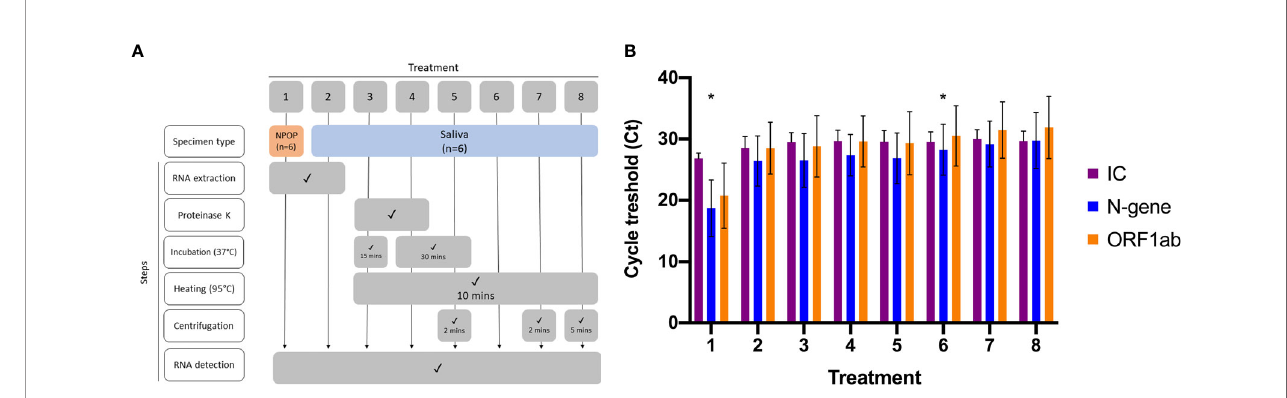
FIGURE 1 | Optimization of RNA-Extraction-free treatment. (A) Flowchart of eight different sample treatments prior SARS-CoV-2 detection (B) Bar graph represents means ± SEM of three SARS-CoV-2 positive specimens tested for each sample treatment. Asterisk (*) denotes the treatments for comparison, where 1 is the comparative method while 6 is the